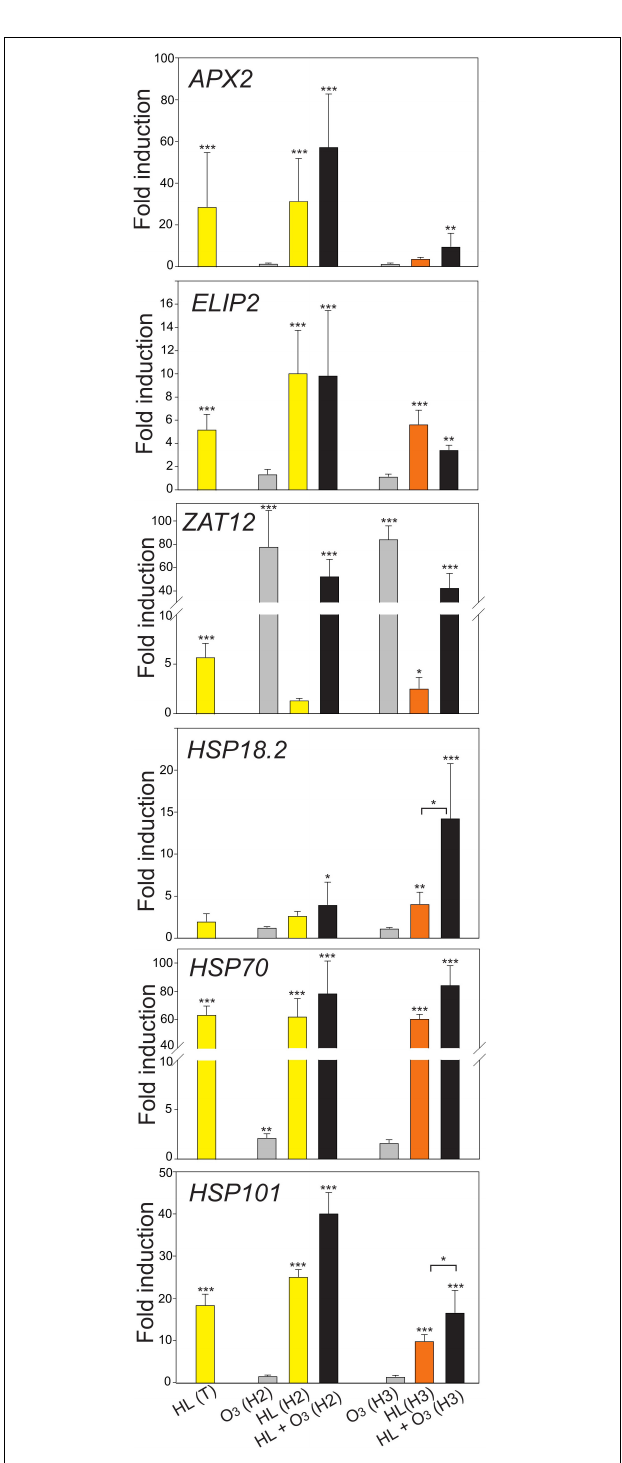
FIGURE 2 | Expression of HL and heat stress marker genes, displayed as fold induction after 1 h HL, O 3 or combined treatment. For exact experimental conditions see Table 1 , T, Turku; H2, Helsinki 2; H3, Helsinki 3. The average of three biological replicates are shown; error bars depict standard deviation. Two-way ANOVA with Tukey’s test was used for statistical analysis and depicts significant differences compared to Col-0 control (* P < 0.05; ** P < 0.01; *** P <